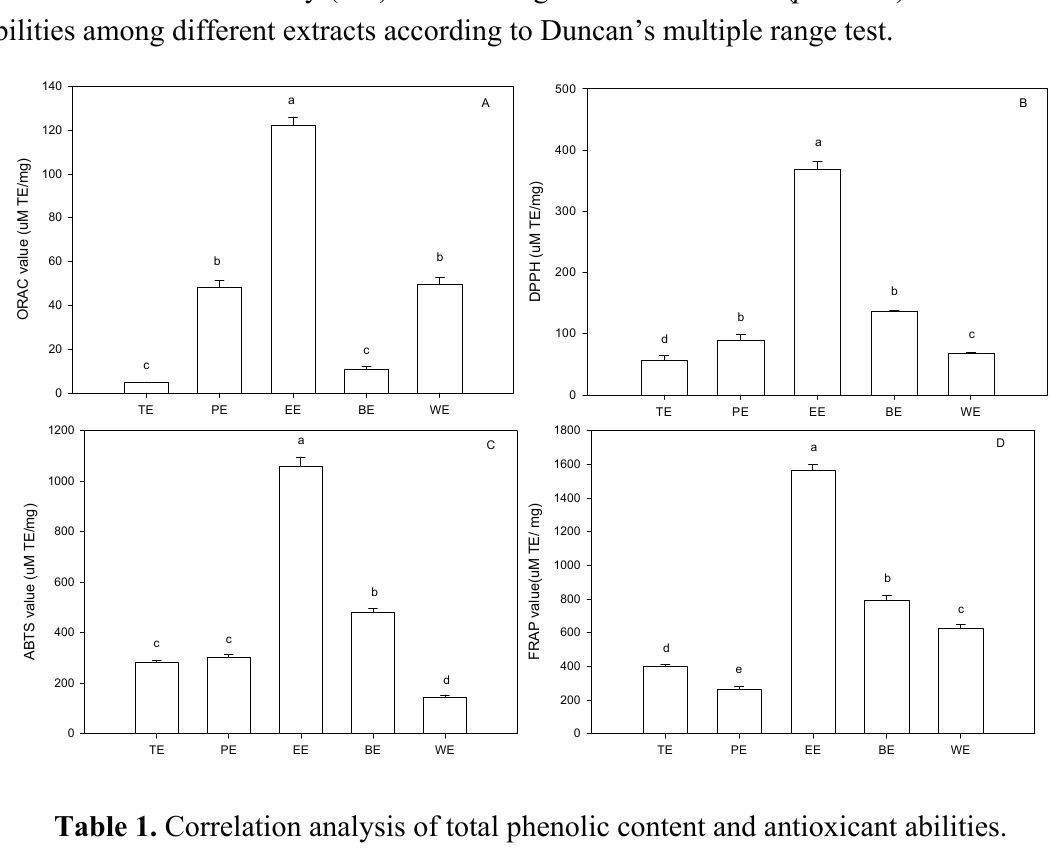
DPPH radical-scavenging capacities assay ( B ), ABTS radical-scavenging capacities assay ( C ) and FRAP assay ( D ). TE, PE, EE, BE, and WE were the abbreviations of total extract,